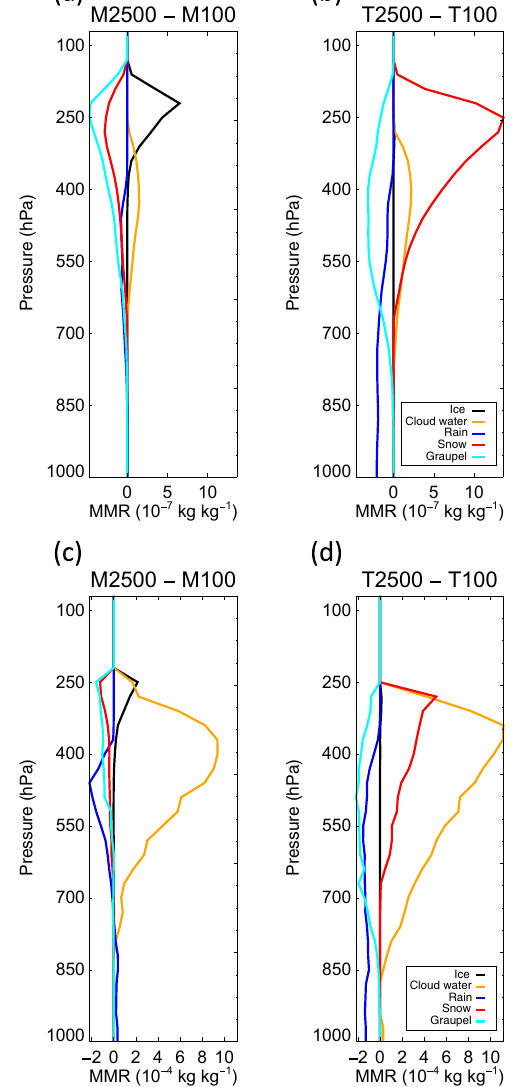
Figure 9. Idealised supercell: difference in the mean hydrome- teor mixing ratio profiles under polluted and pristine conditions, as in Fig. 7, averaged over the 2h of the supercell simulation. (a) SUPER-M2500 cloudy column domain mean minus SUPER- M100 domain mean, (b) SUPER-T2500 domain mean minus SUPER-T100 domain mean, (c) SUPER-M2500 condensate mean of each hydrometeor class minus SUPER-M100 condensate mean and (d) SUPER-T2500 condensate mean minus SUPER-T100 con- densate mean.